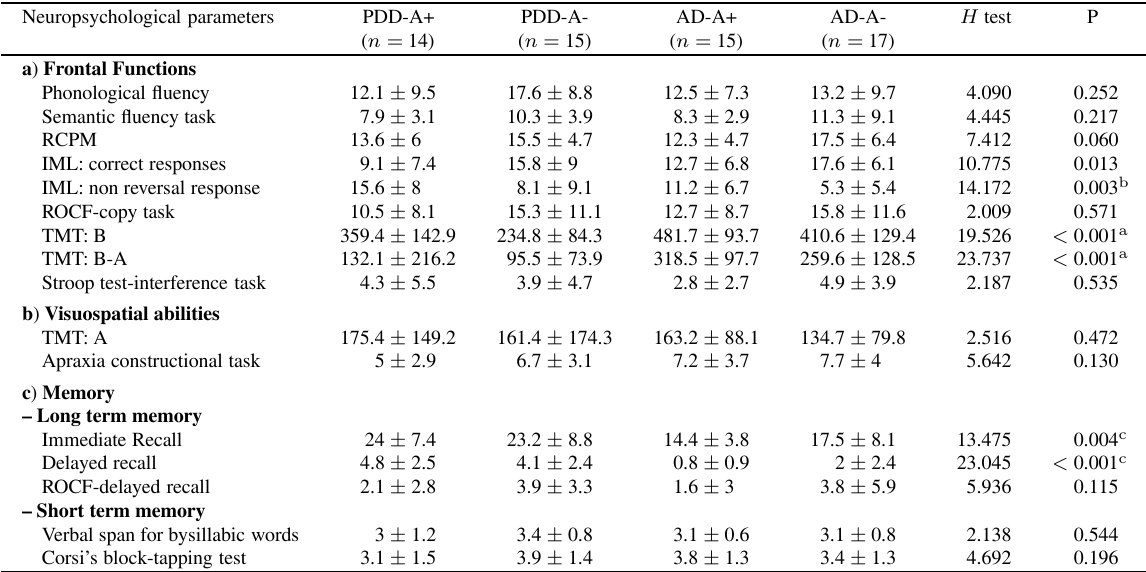
Table 3 Cognitive comparisons among apathetic patients with PD-associated Dementia (PDD-A+), non apathetic patients with PD-associated